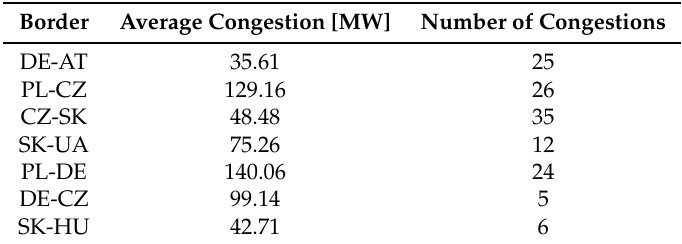
Table 1. Average congestion severity (when the congestion is non-zero) and total number of congested CBCOs per border across 24 grid scenarios. Source: own